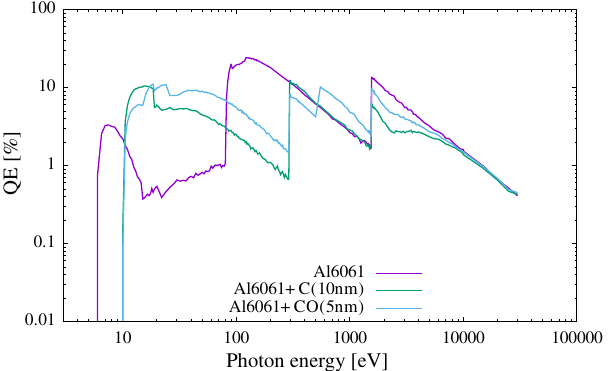
FIG. 16. Quantum efficiency versus photon energy for photons incident at a 5° grazing angle, for the aluminum alloy 6061, oxide layer. The quantum efficiency is sharply enhanced at oxygen K (543 eV), and aluminum K (1560 eV).